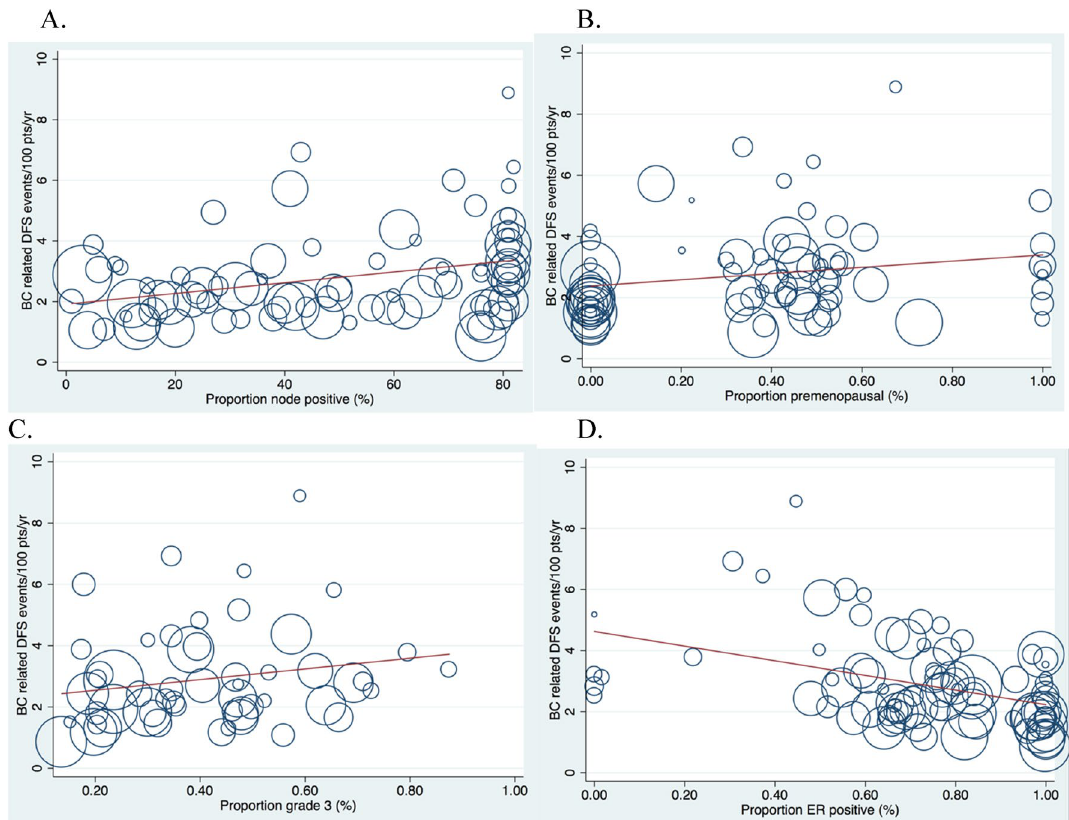
Figure 3. ( A – D ) BC related DFS event rate/per 100 participants/year as a percentage of all participants randomized, stratified by co-variates. ( A ) % of participants node positive (n = 84). ( B ) % pre menopausal (n = 75). ( C ) % grade 3 (n = 53). ( D ) % ER positive participants (n = 84).